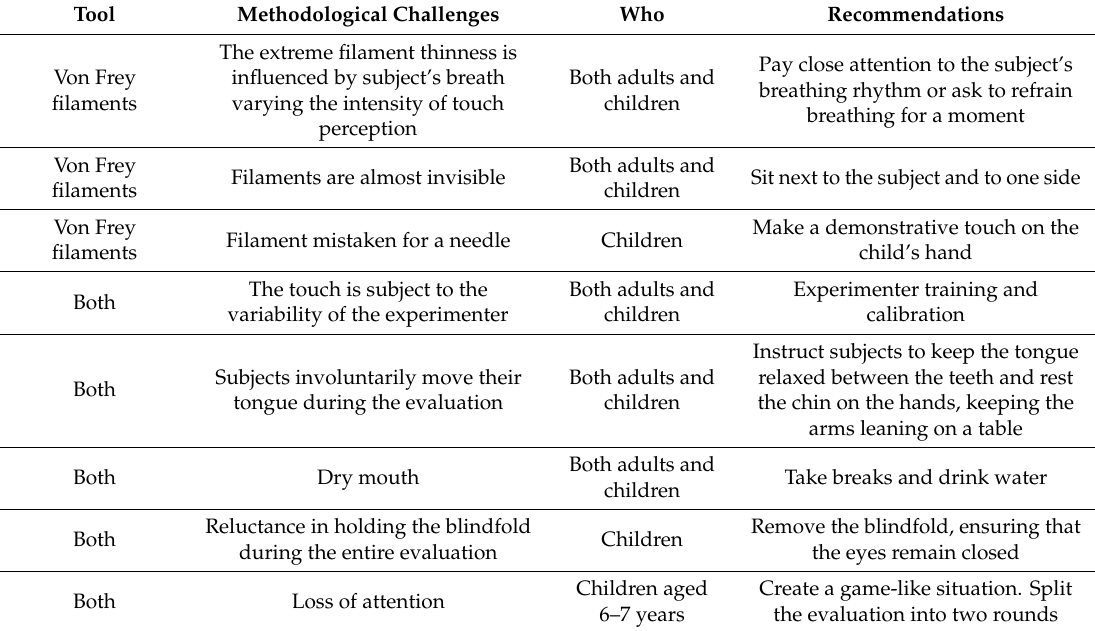
Table 6. Summary of the methodological challenges encountered in the evaluation of lingual tactile sensitivity in children and adults and possible